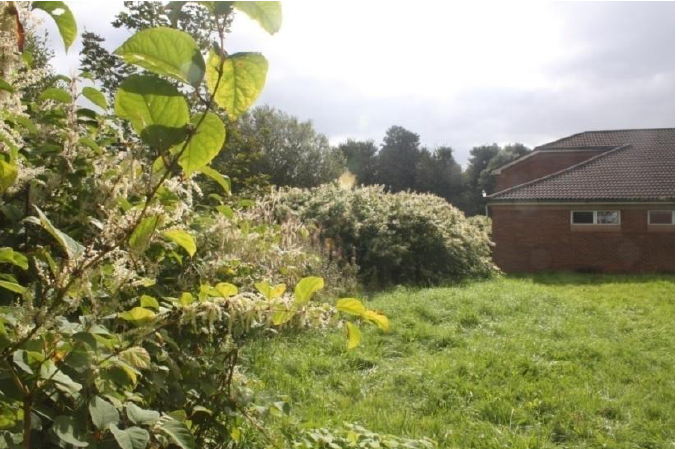
Figure 10. Points 1 and 2 (51°64′43.0″N, 03°82′48.5″W) F. japonica var. japonica stand(s) detected by algorithm, but not by specialist field survey. Image capture: